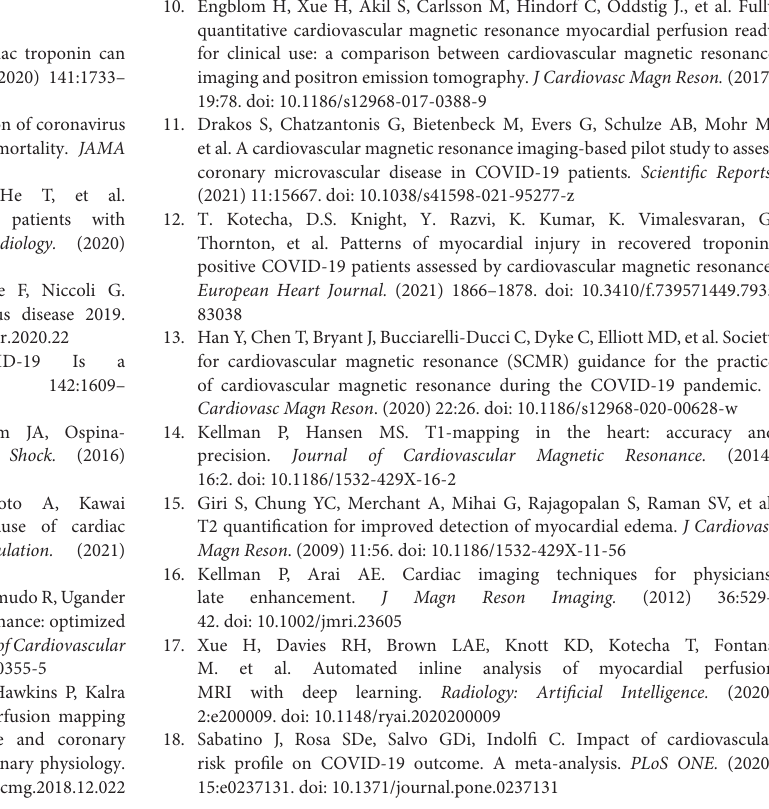
differences. Supplementary Figure 1 | CMR imaging protocol for the study. Supplementary Figure 2 | Perfusion Mapping Quality Assurance and Outputs. Supplementary Figure 3 | CONSORT diagram describing the pathway from the clinical CMR post-COVID to the final number of patients who underwent stress